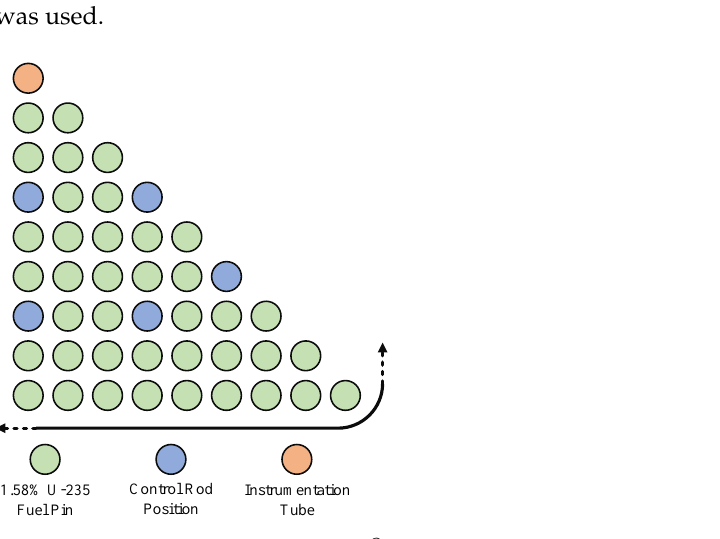
Figure 1. Radial pin layout of AP1000 ® Region B